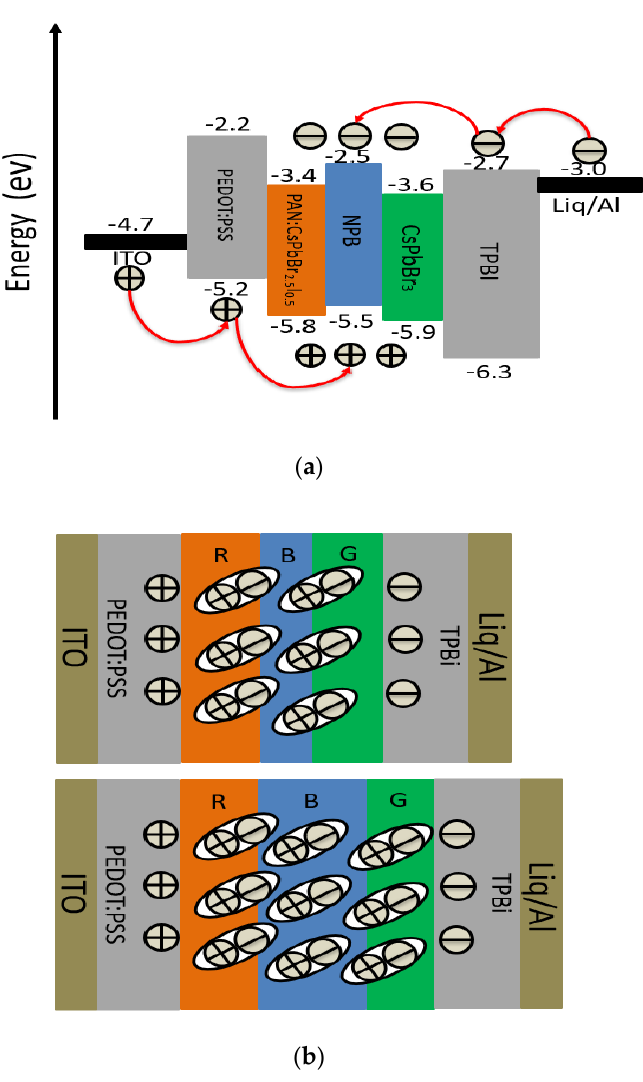
Figure 8. ( a ) Device energy level diagram of the white PeLED; ( b ) schematic diagram of the exciton distribution in the luminescent layer.